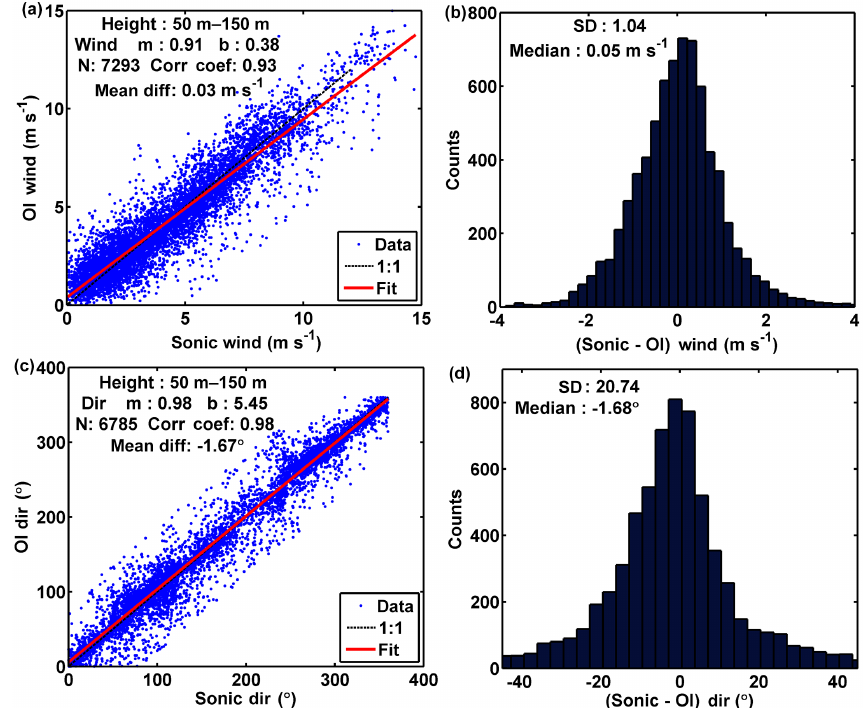
Figure 13. Comparison of the (a, b) wind speed and (c, d) wind direction measurements from the single-Doppler OI technique with the measurements made by the sonic